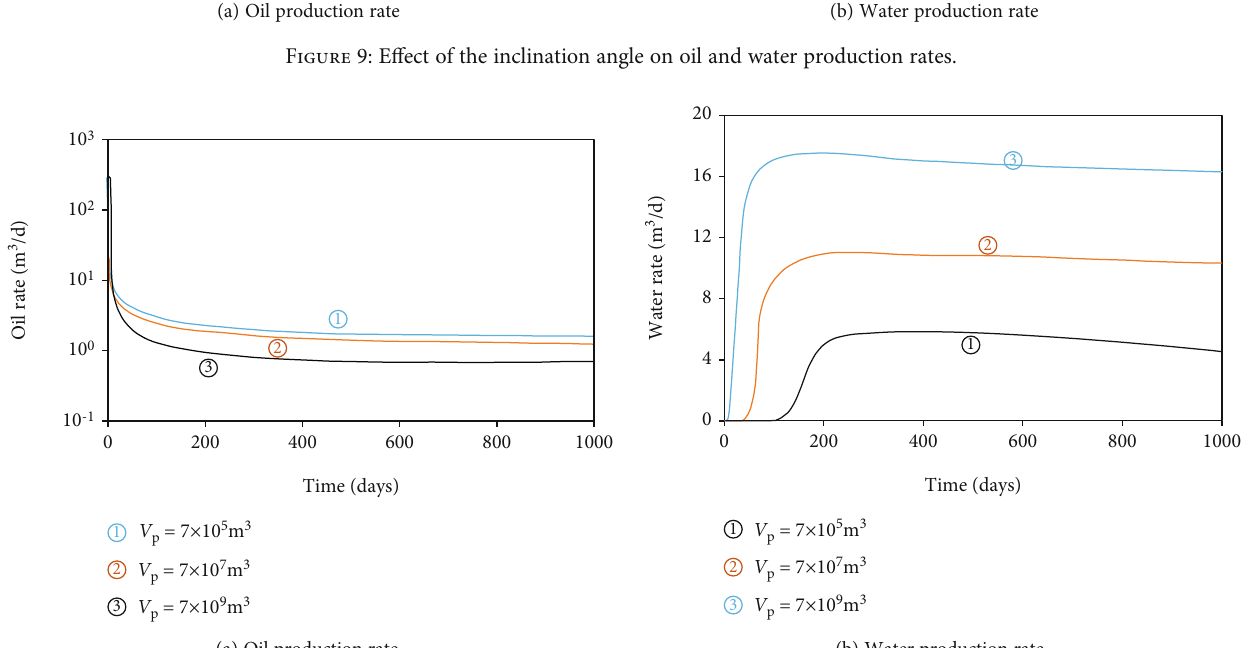
Figure 10: E ff ect of the aquifer size on oil and water production rates.